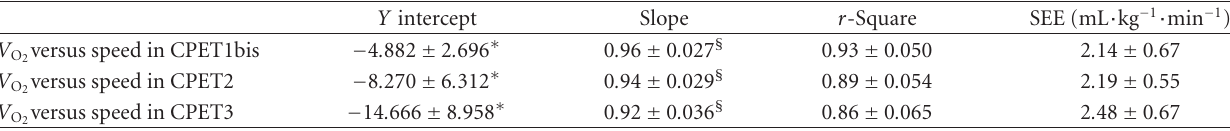
Table 5: Intercept, slope, R -square ( r 2 ), and standard error of estimate (SEE) for the regression models obtained in ramp protocols initiating (CPET1bis), 50% of the measured V O (CPET2), and 60% of the measure with speeds corresponding to 50% of the estimated V O 2 max 2 max V O 2 max (CPET3). Y intercept Slope r -Square SEE (mL · kg − 1 · min − 1 ) V − 4 . 882 ± 2 . 696 ∗ 0 . 96 ± 0 . 027 § 0 . 93 ± 0 . 050 2 . 14 ± 0 . 67 O 2 versus speed in CPET1bis V − 8 . 270 ± 6 . 312 ∗ 0 . 94 ± 0 . 029 § 0 . 89 ± 0 . 054 2 . 19 ± 0 . 55 O 2 versus speed in CPET2 V − 14 . 666 ± 8 . 958 ∗ 0 . 92 ± 0 . 036 § 0 . 86 ± 0 . O 2 versus speed in CPET3